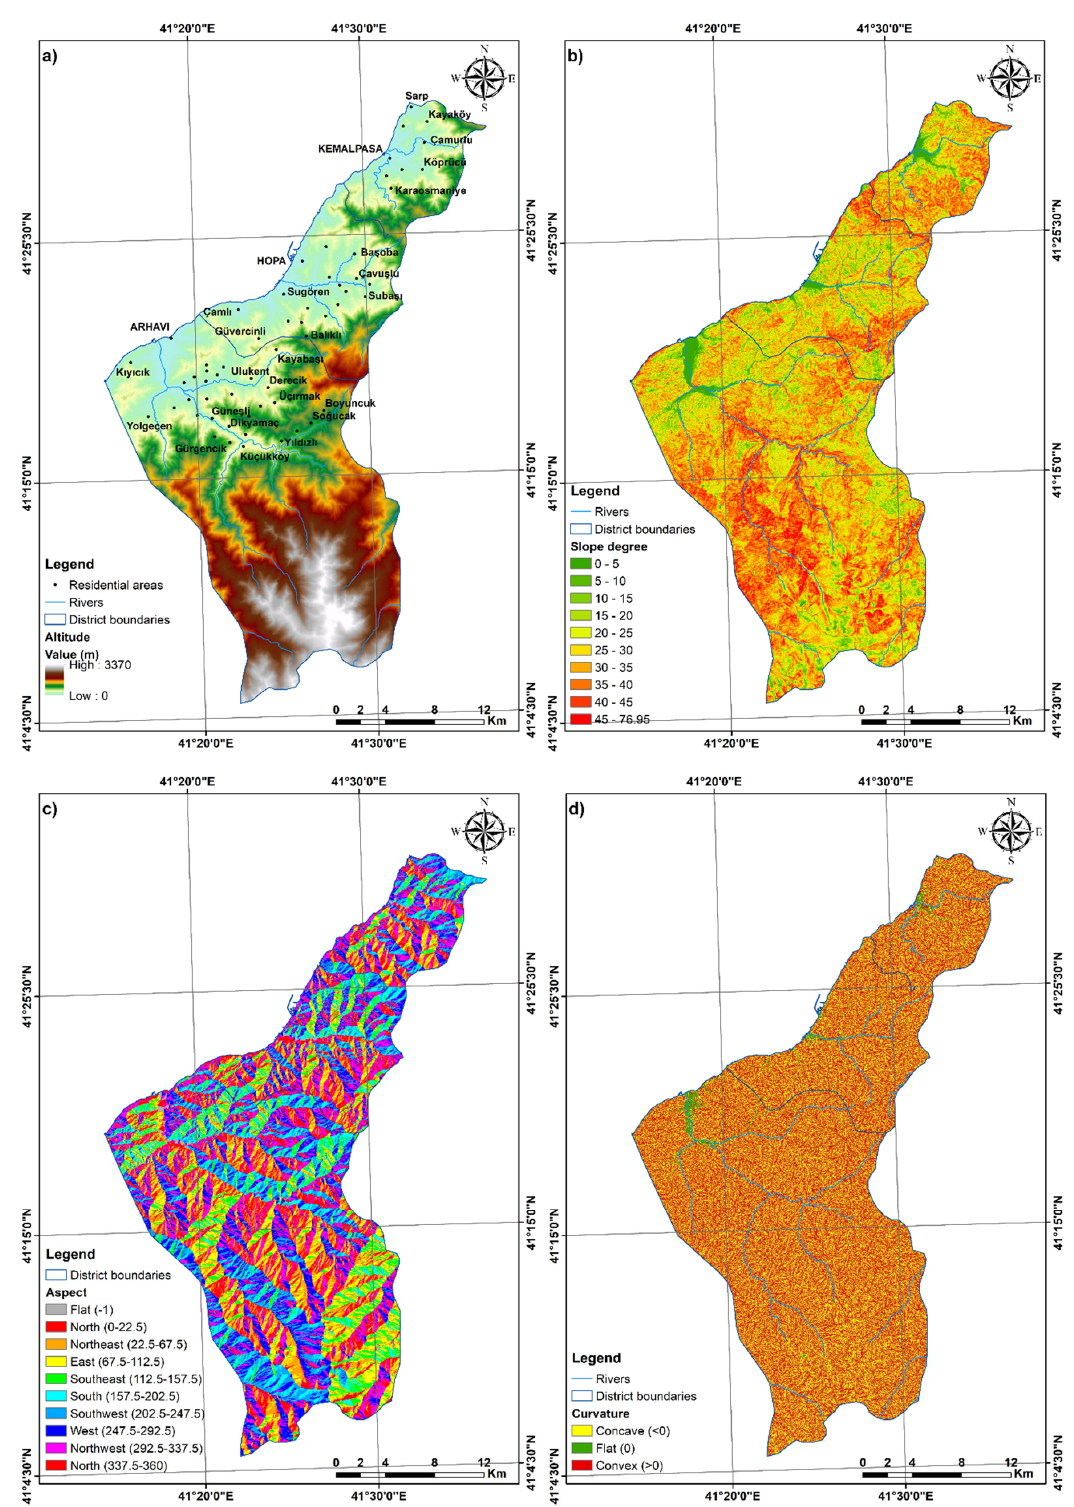
Figure 2. Topographic factor maps a) elevation; b) slope; c) aspect; and d) curvature.